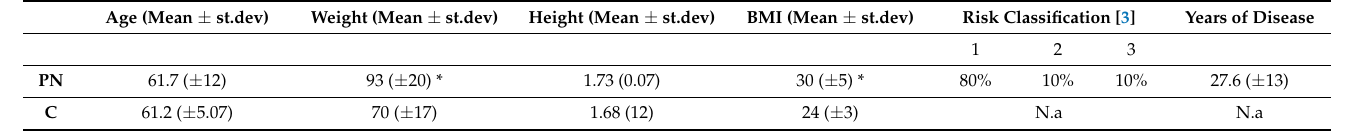
Figure 2. Details of sEMG probes location. 2.3. Custom Insoles Details of CI are reported in Table 2. Table 2. Technical details of CI. Subject Prescription Production Method